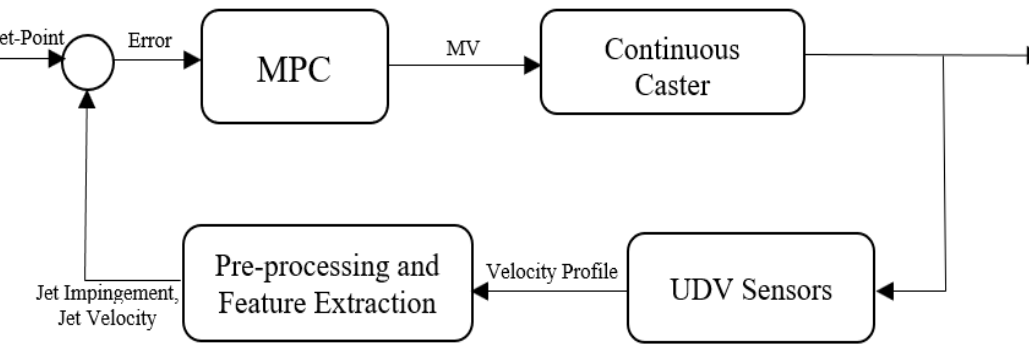
Figure 13. Control loop based on measured velocity profile from ultrasound Doppler velocimetry.